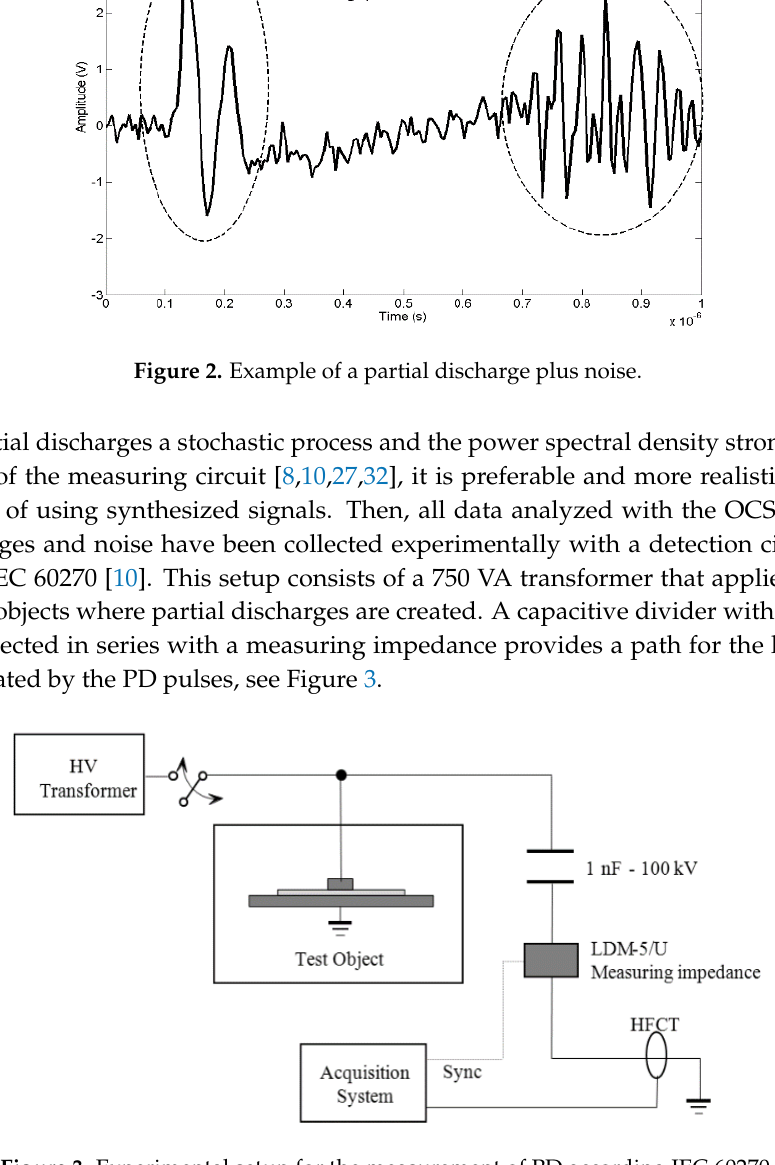
Figure 3. Experimental setup for the measurement of PD according IEC 60270.